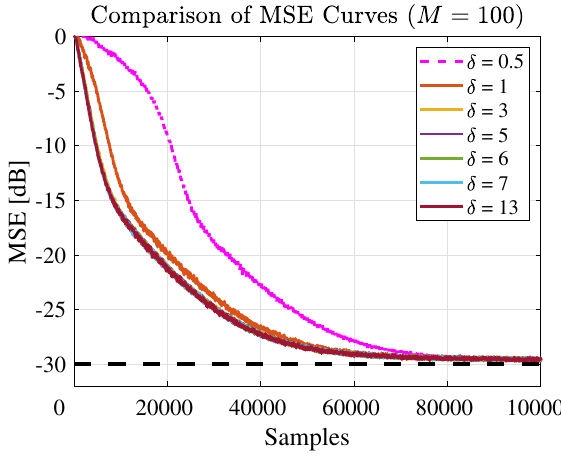
Figure 2. MSE curves of FDSAF-MCC different δ parameters.